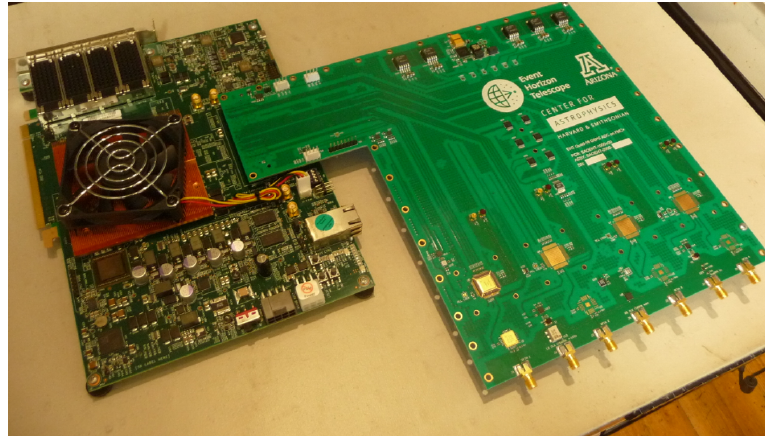
Figure 2. The FPGA evaluation and custom ADC board set proof-of-concept platform. This is a general-purpose open-source platform, which, at SAO, will find application as the ngEHT digital backend and wSMA D-engine. The left board in the set is a commercial-off-the-shelf (COTS) Xilinx VCU128 FPGA evaluation motherboard. The right board is a custom plug-in to the VCU128’s “FPGA Mezzanine Card +” (FMC+ or VITA 57.4) standard high-speed connector. This custom ADC board has four analog inputs leading to four Adsantec ASNT7123A ADC chips, each proven to run at 16.384 gigasamples-per-second (GS/s). The 4 × 100 GbE QSFP28 network ports on the FPGA motherboard can connect to the F-engines of the wSMA correlator or ngEHT